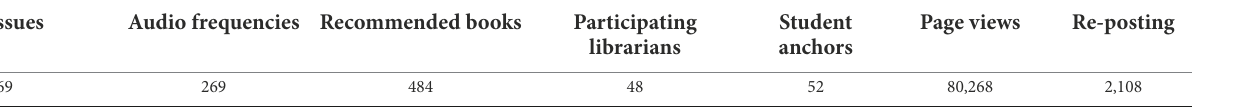
TABLE 1 The achievements of RTLE